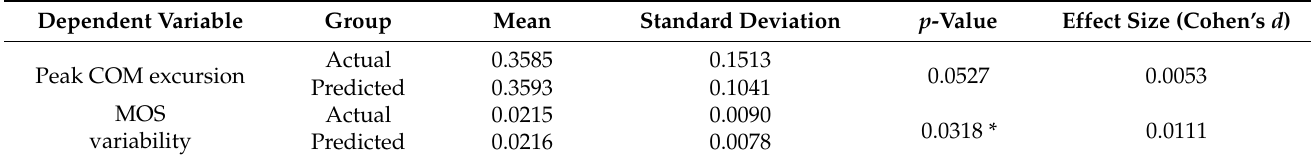
Table 6. Results of the paired t -test and effect size between the actual and predicted values for peak COM excursion and MOS variability (* indicates p <